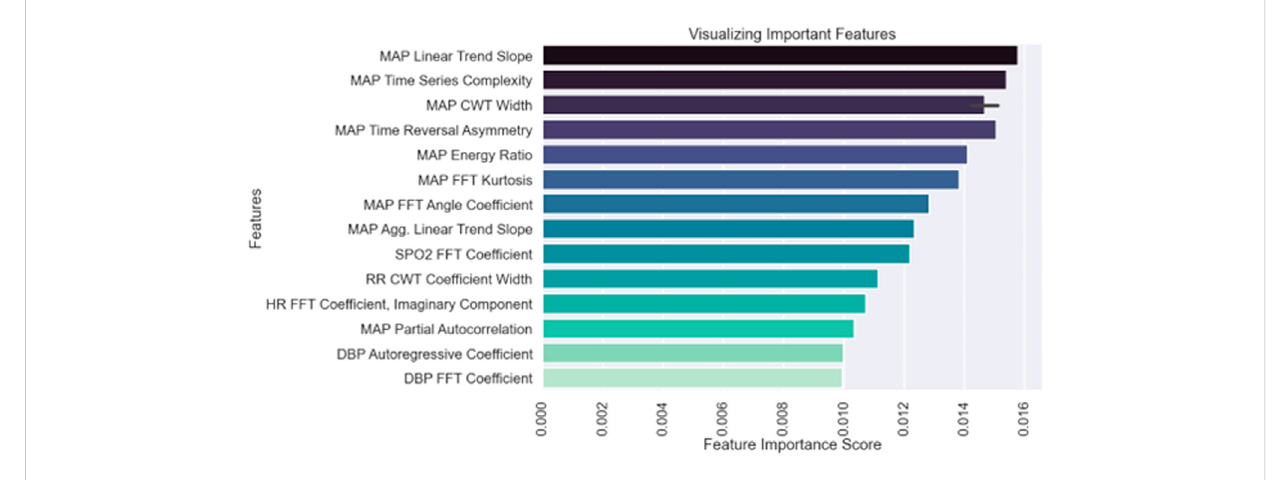
FIGURE 5 Top 15 signi fi cant features from PTS data (M3).